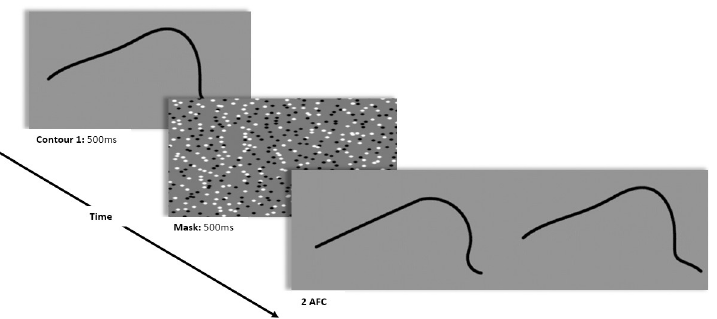
Fig 7. Sample trial for Experiment 2. The nonconstant curvature contour was shown first, followed by a mask. Then, a constant curvature representation and the original contour were shown side-by-side. Here, the constant curvature representation is generated with a window size of 2.25 degrees of visual